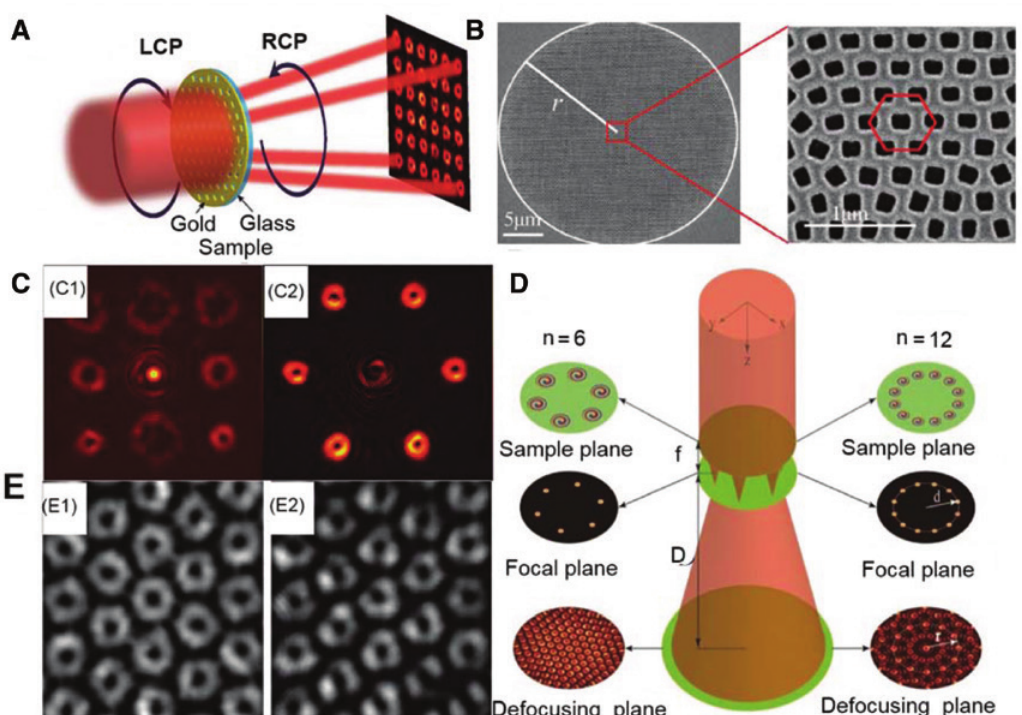
Figure 11: Optical vortex arrays generated via planar metasurfaces. (A) Illustration of the multi-channel vortex beam generation enabled by a metasurface. (B) SEM picture of the 6 × 6 OAM beam generator. (C) Multi-channel OAM beams with various topological charges (C1) and hexagonal profile (C2). Reprinted from Ref. [240]. (D) Illustration of the principle on the quasi-Talbot effect of OAM beams whose centers are placed in a rotationally symmetric position. (E) Numerical (E1) and experimental (E2) results of the vortex array by the predesigned metasurface on the defocusing plane. Reprinted from Ref.